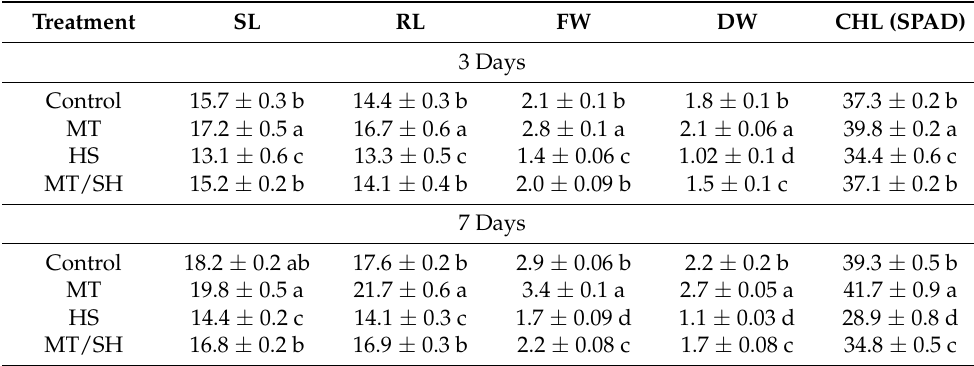
Table 1. Effects of melatonin application on growth attributes of soybean plants 3 and 7 days after heat